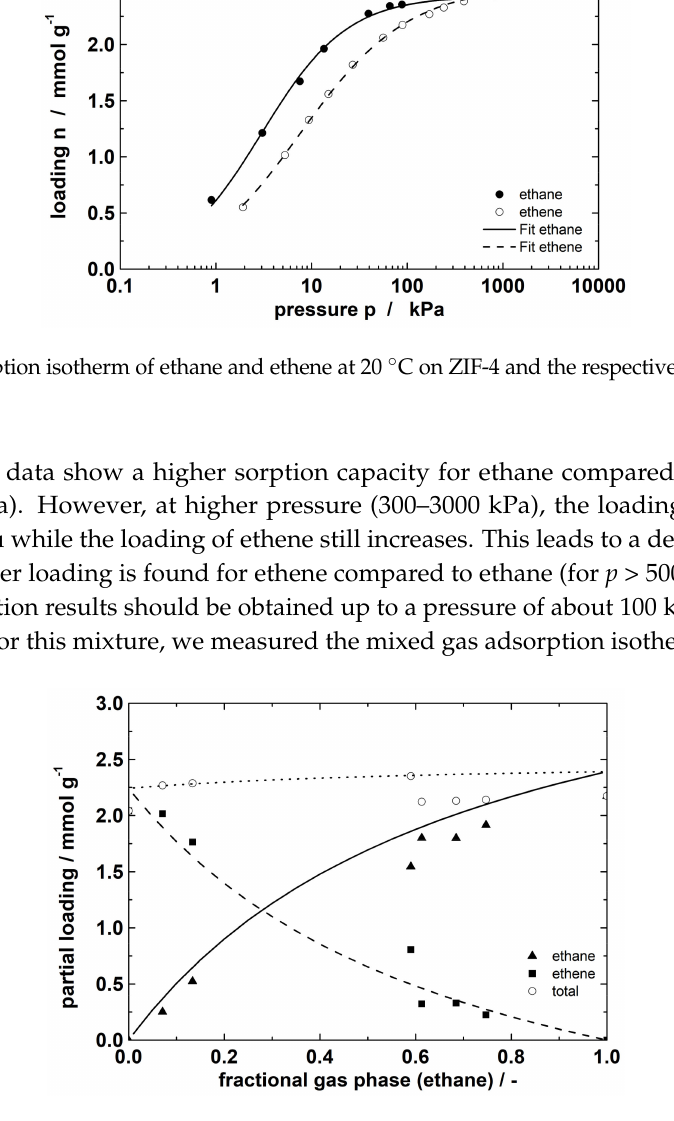
Figure 2. Mixed adsorption equilibria for ethane/ethene at a total pressure of 100 kPa and 20 ◦ C on ZIF-4. Lines demonstrate calculated data from ideal adsorbed solution theory (IAST) based on Toth fit from single gas